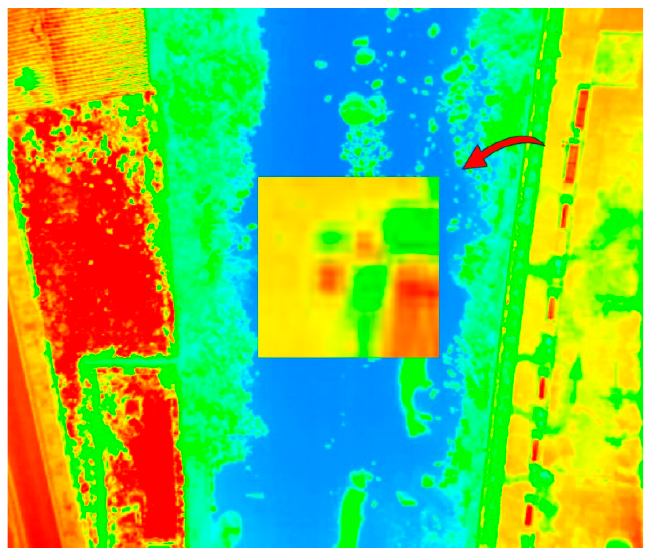
Figure 5. Detail of a GCP on thermal image.